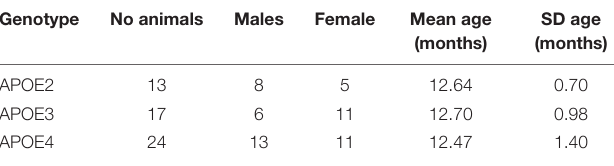
TABLE 1 | Animal groups distribution by genotype, sex, and age